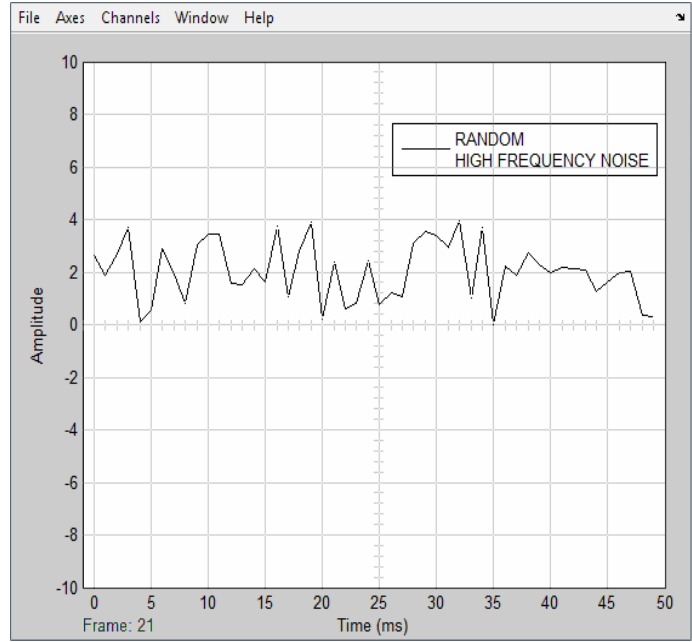
Figure 8. The random high frequency noise used in the Simulink